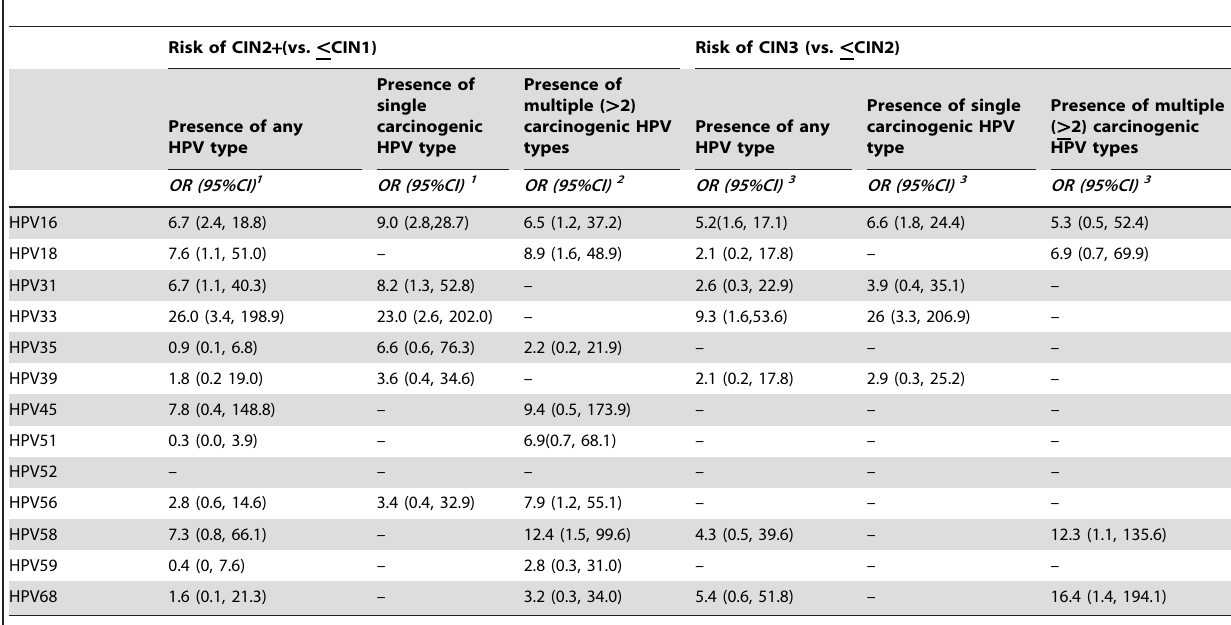
Table 3. Relationship of prevalent carcinogenic HPV genotypes (present singly or concurrently with carcinogenic types) with risk of CIN2 + and CIN3 in HIV-infected women in Pune,